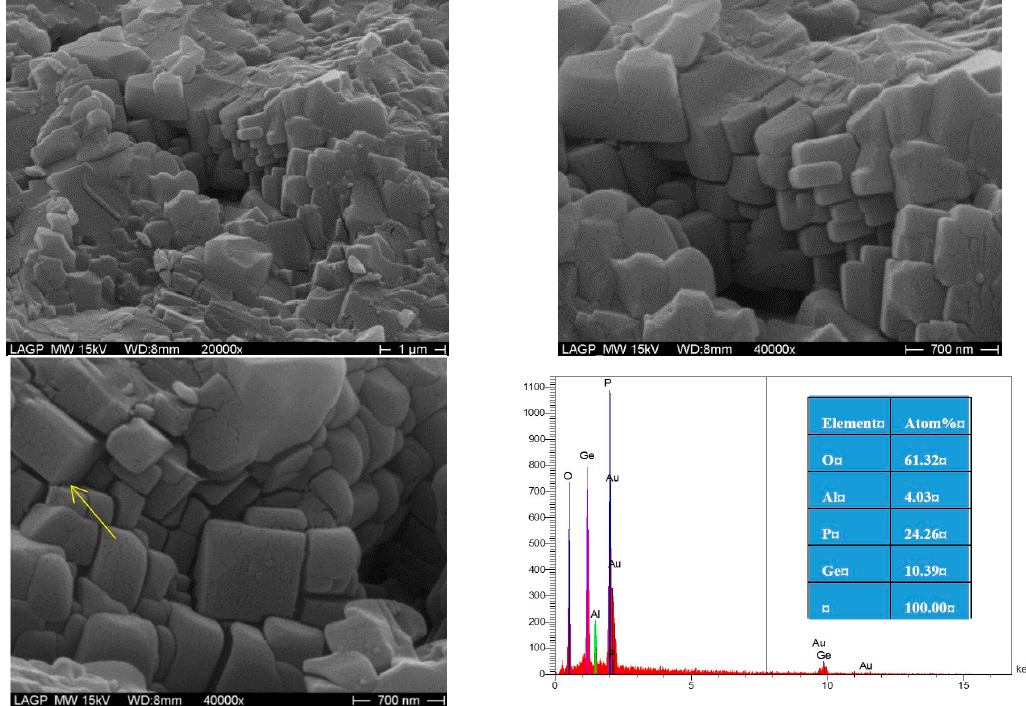
Figure 6. SEM micrographs with EDX data of LAGP glass-ceramics sample heat-treated at 800 °C for 6 h using 30 GHz microwave heating.